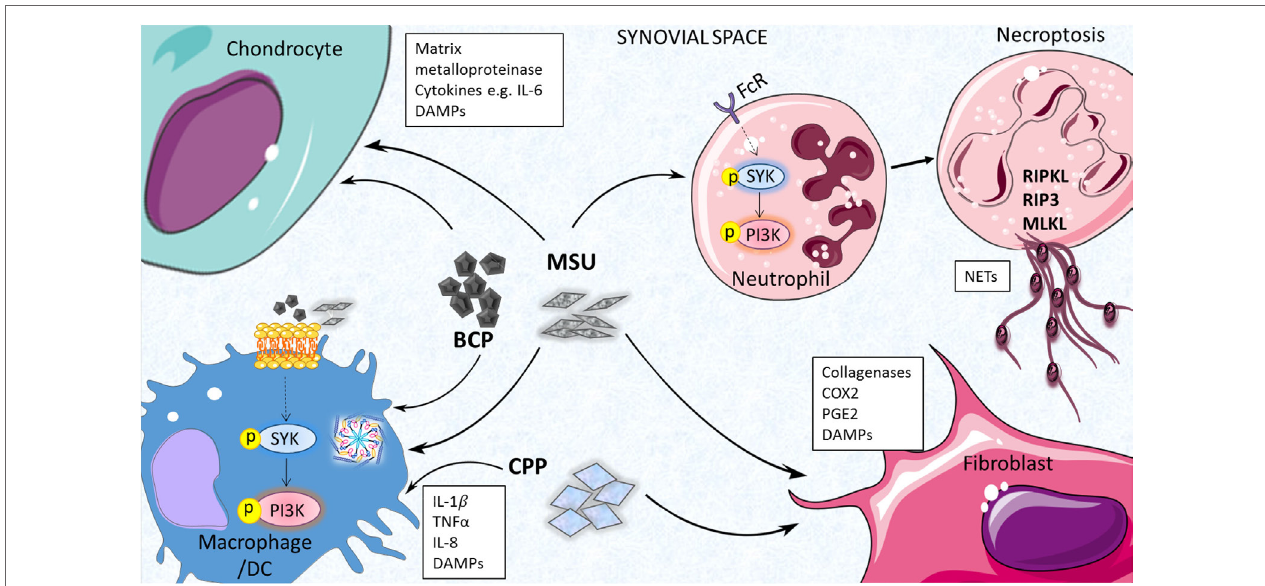
FiGURe 1 | Inflammatory processes driven by endogenous joint-associates particulates. Monosodium urate (MSU), basic calcium phosphate (BCP) and calcium pyrophosphate (CPP) crystals can act on a number of cell types in the joint to drive pro-inflammatory cytokine production, matrix metalloprotease (MMP) expression, and release of additional damage-associated molecular patterns (DAMPs) that contribute further to joint inflammation and cartilage destruction. Inflammasome activation, membrane affinity-triggered signaling, and neutrophil-mediated neutrophil extracellular trap (NET) formation have been implicated in these